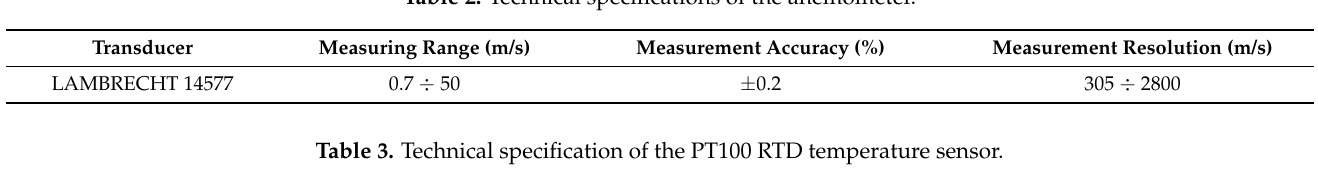
Table 2. Technical specifications of the anemometer.